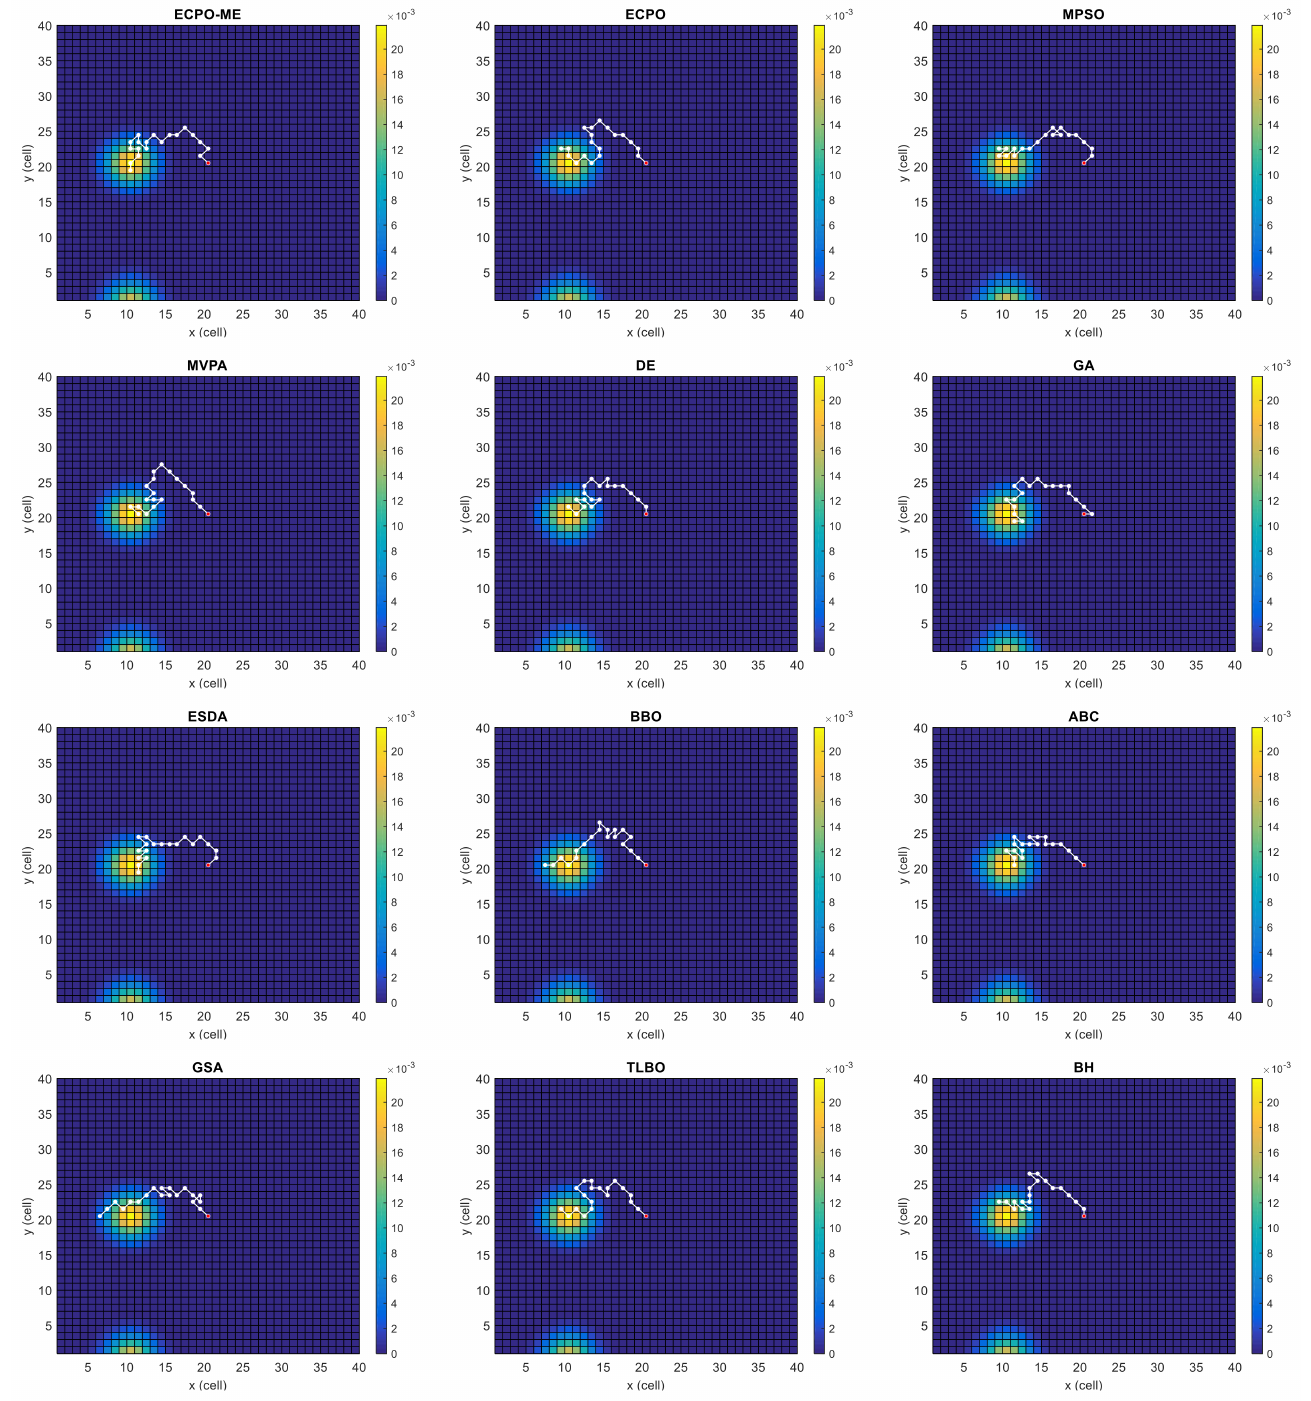
Figure 5. Search paths for Scenario B, obtained using the tested